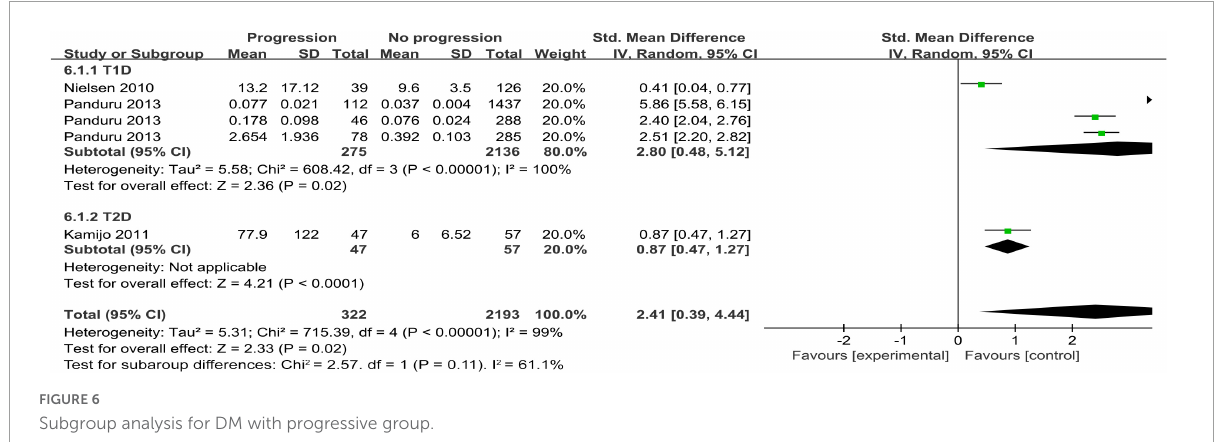
FIGURE6 Subgroup analysis for DM with progressive